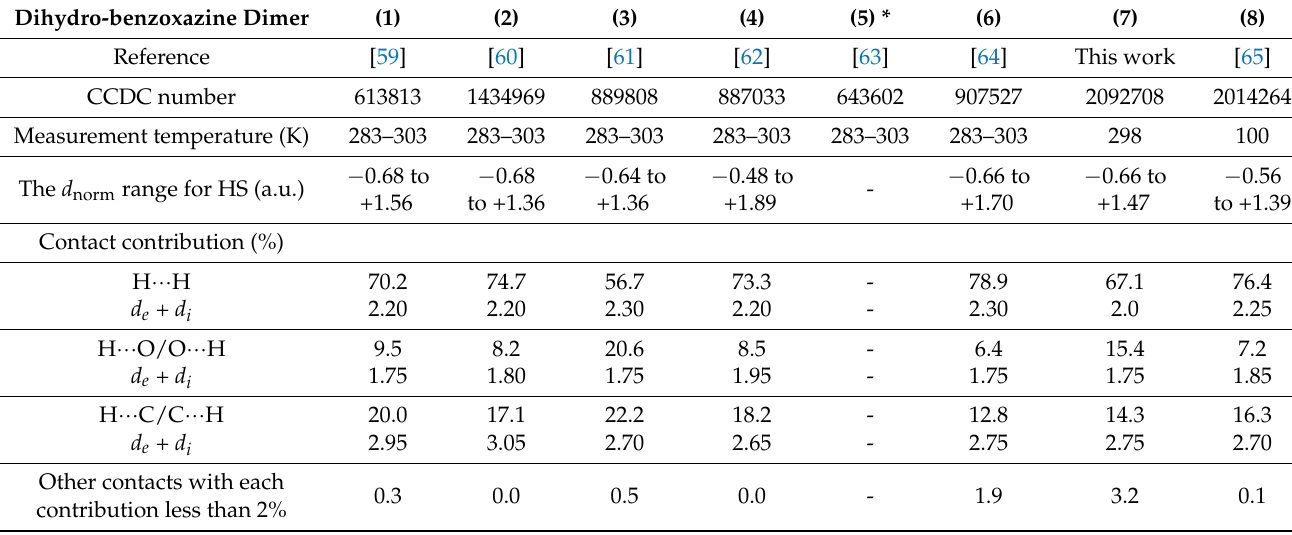
Figure 4. The two-dimensional fingerprint plots showing ( a ) all interactions and those delineated into ( b ) H ··· H, ( c ) H ··· O/O ··· H, and ( d ) H ··· C/C ··· H interactions, together with their corresponding views of the Hirshfeld surface for the compound (7). Note that Hirshfeld surface is mapped over d norm in the range from − 0.66 to +1.47 arbitrary units and the d i and d e values are the closest internal and external distances (in Å) from given points on the Hirshfeld surface. Table 4. Contributions of the contacts found in the crystals of most of the eight dihydro-benzoxazine dimers derivatives calculated from the 2D fingerprint plots of the Hirshfeld